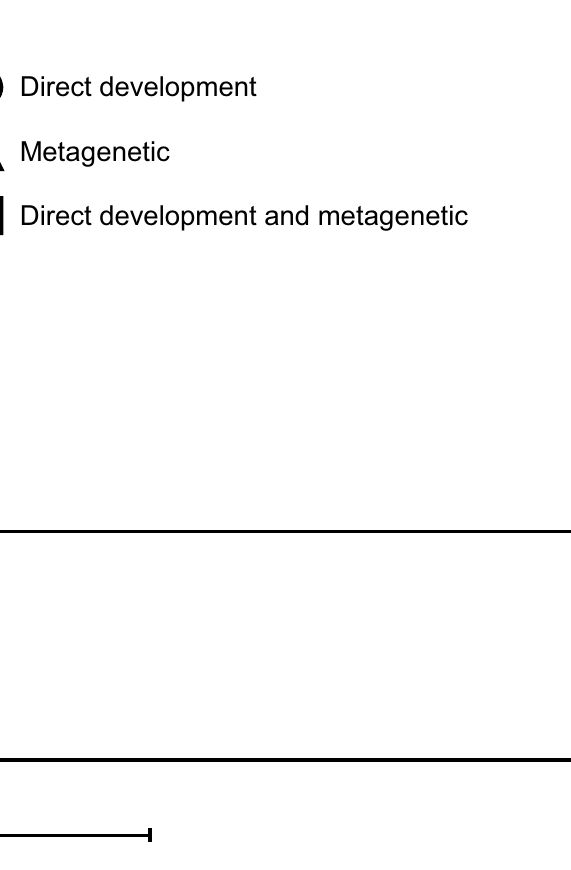
Fig 10. COI phylogenetic relationships among Aurelia of the two life cycle types in Maizuru Bay and A . coerulea from the North Pacific. The tree with the highest log likelihood (-862.22) is shown. Circle, triangle, and square indicate haplotypes that include specimens from the direct-development period, metagenetic period, and both periods, respectively. The letters following the symbols indicate the number of specimens from the direct-development (D) and metagenetic types (M). Bootstrap values > 50% are shown adjacent to branches. The scale bar indicates the number of substitutions per site. A . limbata was used as an outgroup.